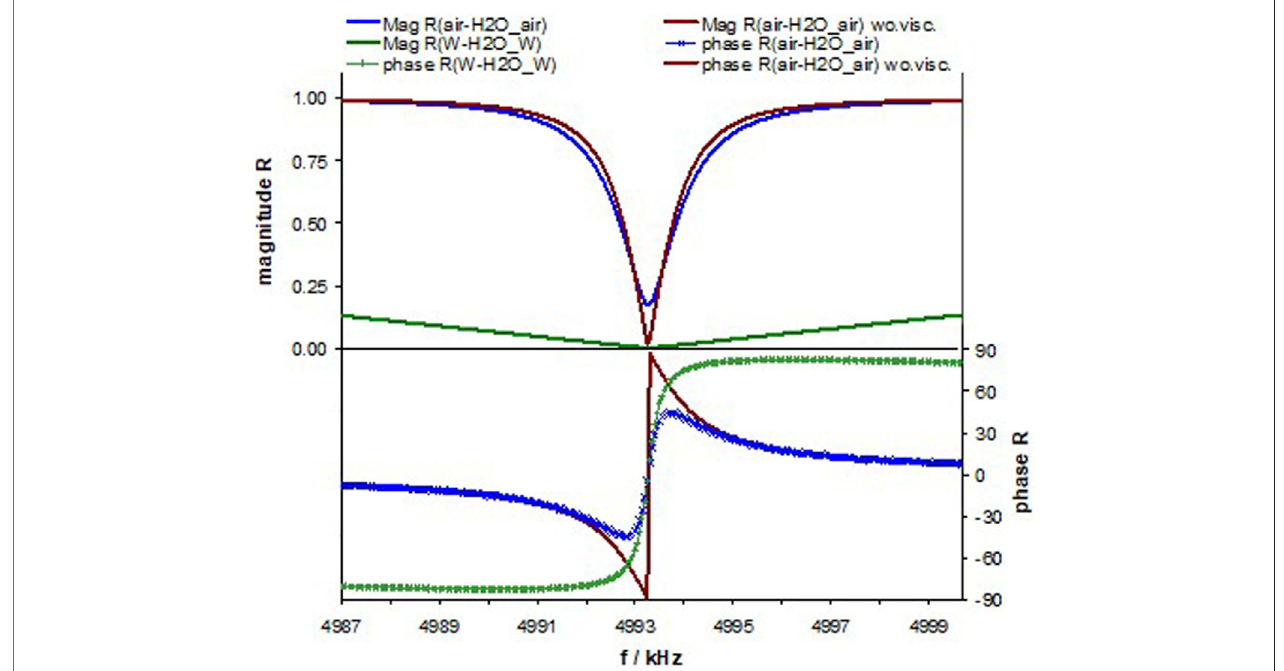
FIGURE 2 | Magnitude and phase of the re fl ection coef fi cient, R , at the interface of a single water layer to either semi-in fi nite metal plates (green) or air (blue), both with viscosity, and air – H 2 O – air without viscosity (brown).